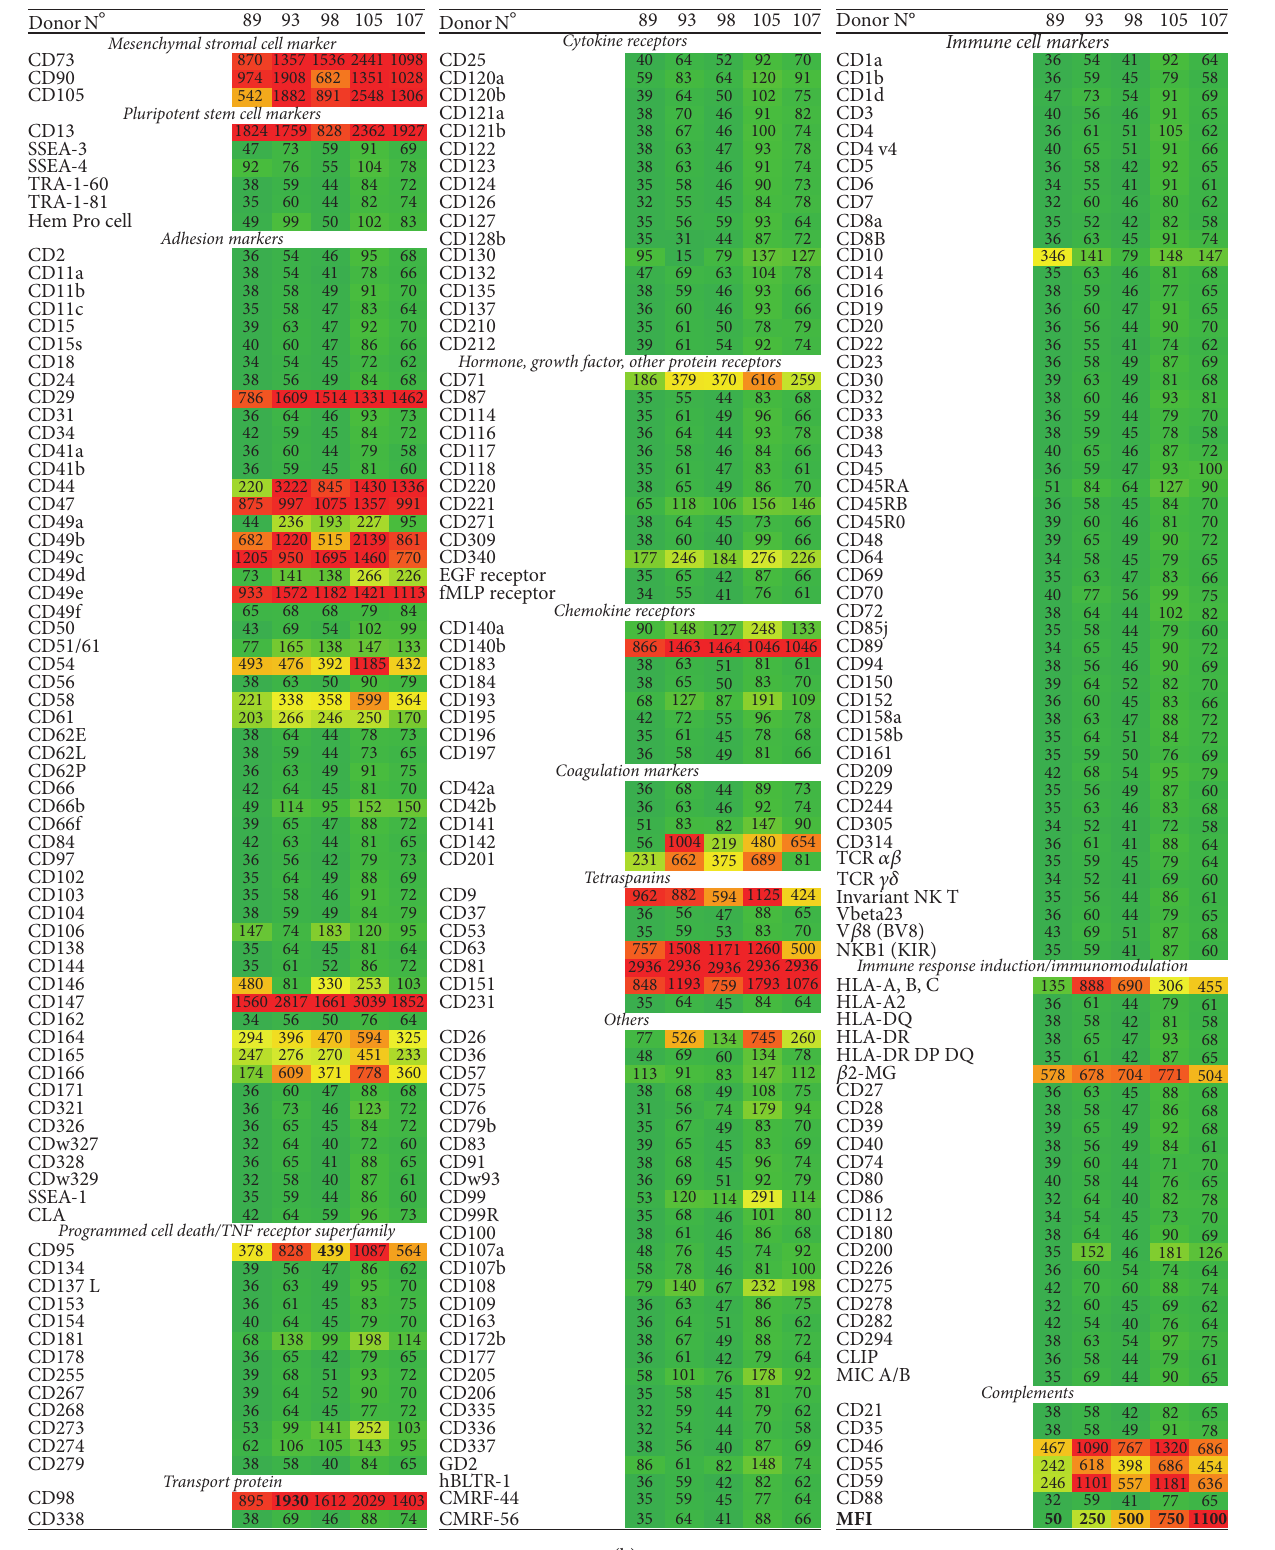
Figure 1: Heat map of cell surface marker expression of ADHLSCs using the BD Lyoplate. Results are expressed as percentage of positive cells (a) and in median fluorescence intensity of the total population (MFI) (b). For reference, isotype controls showed an average MFI of 60 ( 𝑛 = 5